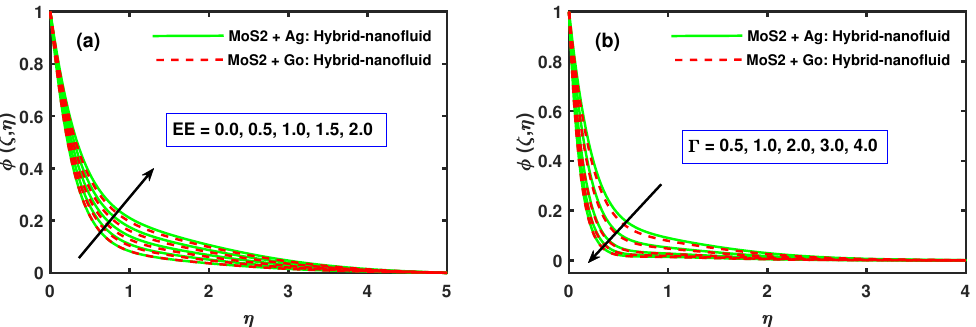
Figure 9. Fluctuation of φ ( ζ , η ) along with EE (activation energy) and Γ (chemical reaction rate) at ζ =